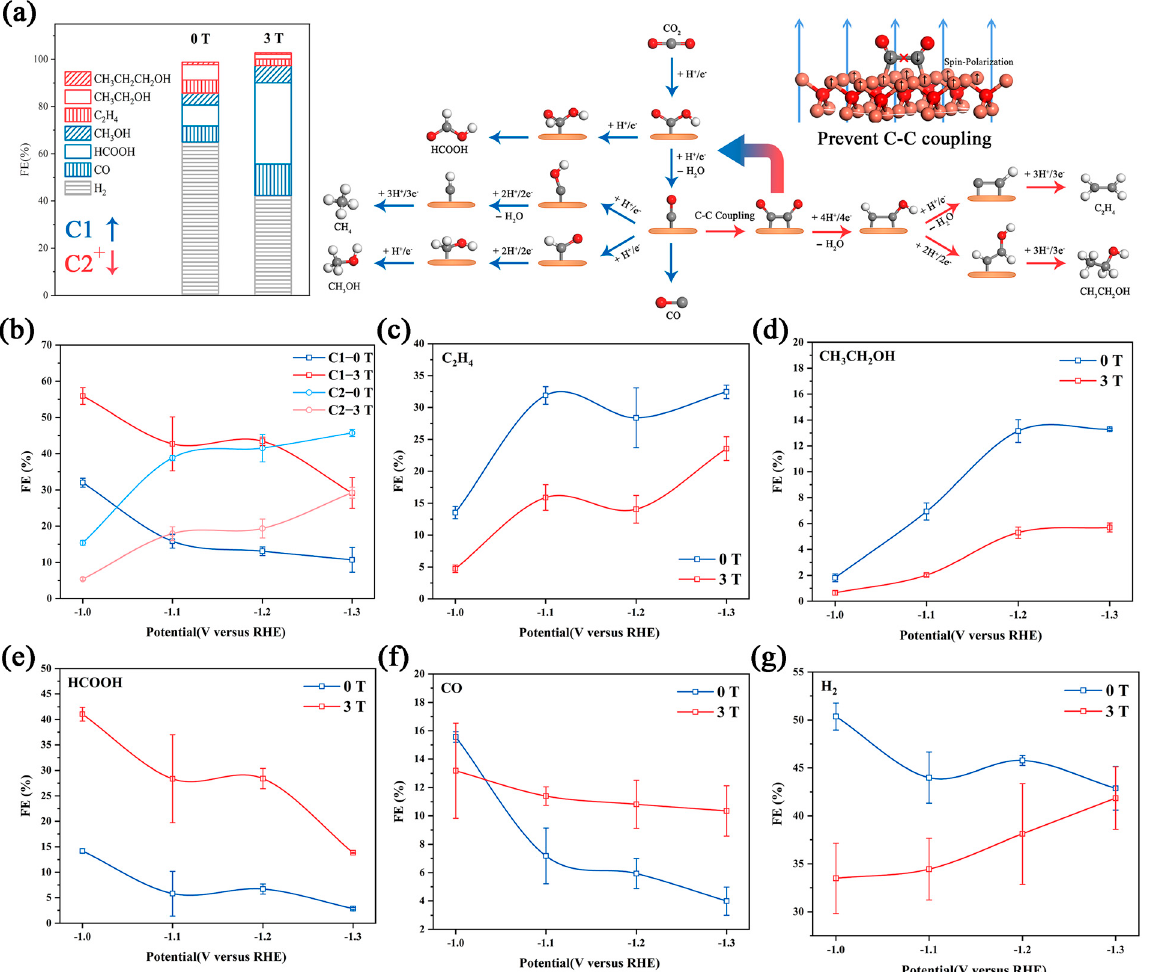
Figure 3 . ( a ) The Faraday efficiency in − 1.1V V RHE under different magnetic fields and the reaction roadmaps of the CO 2 RR on Cu2O catalysts; the red roads are inhibited in the magnetic field by preventing C–C coupling. The Faraday efficiency plot with/without a magnetic field of C 1 , C 2 ( b ), C 2 H 4 ( c ), CH 3 CH 2 OH ( d ), HCOOH ( e ), CO ( f ) and H 2 ( g ). All tests were performed in 0.1 M KHCO 3 , and the error bars represent the s.d. (n = 3).